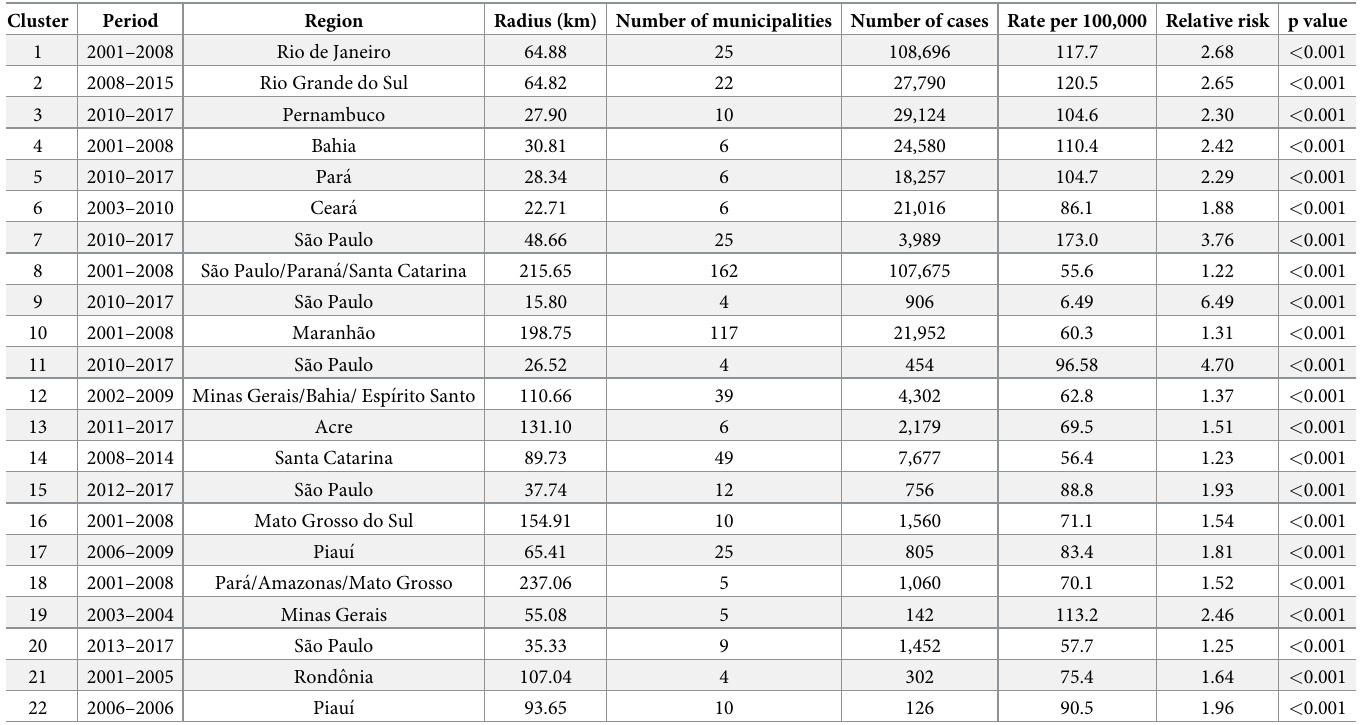
Table 2. Spatial-temporal clusters of tuberculosis. Brazil,